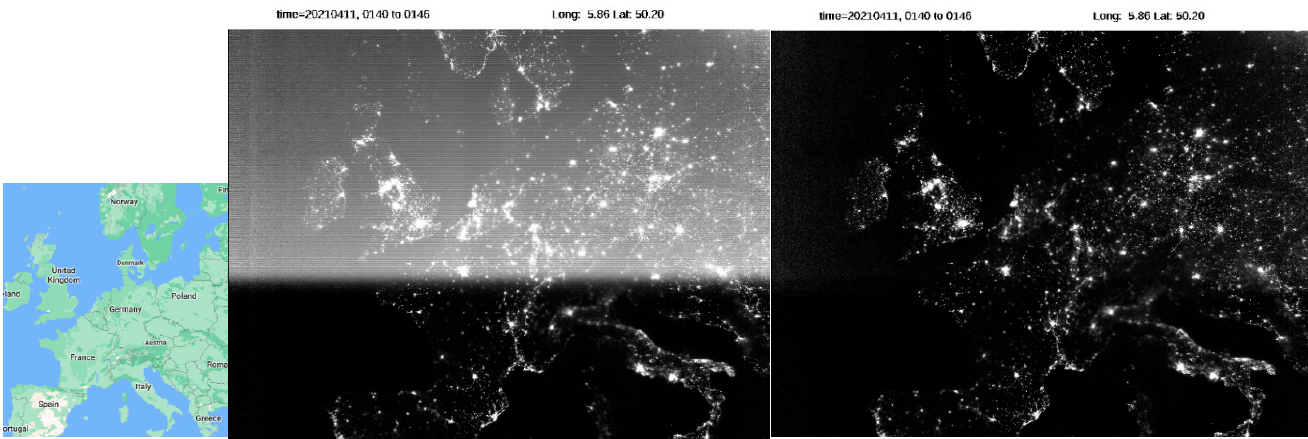
Figure 11. SNPP DNB images from 11 April 2021, 1:40 GMT. Images before/after stray light correction are located middle and right, respectively.